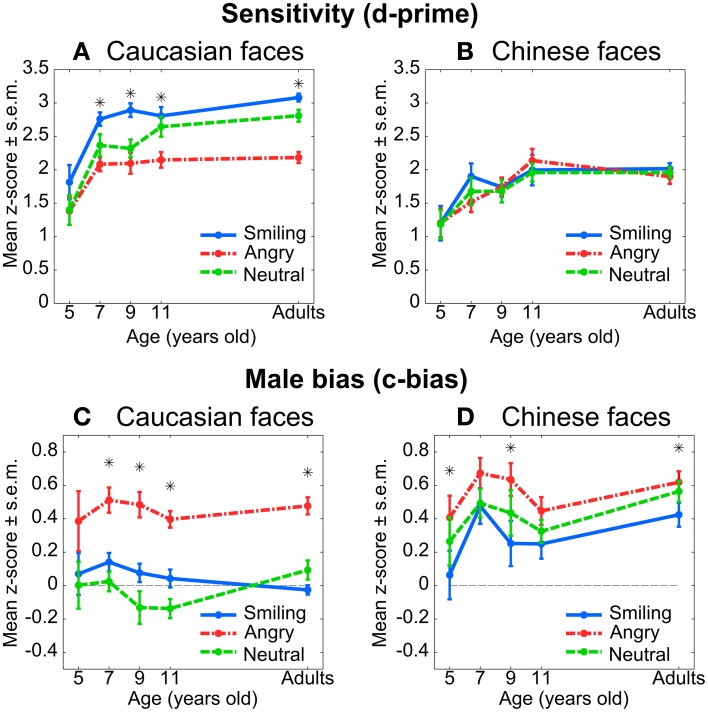
Sensitivity and male bias for gender categorization in Experiments 1 (adults) and 2 (children). Female faces were used as “signal” class. Each star represents a significant difference between angry and smiling faces (paired Student t-tests, p < 0.05, uncorrected). Top: Sensitivity for Caucasian (A) and Chinese (B) faces. Bottom: Male bias for Caucasian (C) and Chinese (D) faces.